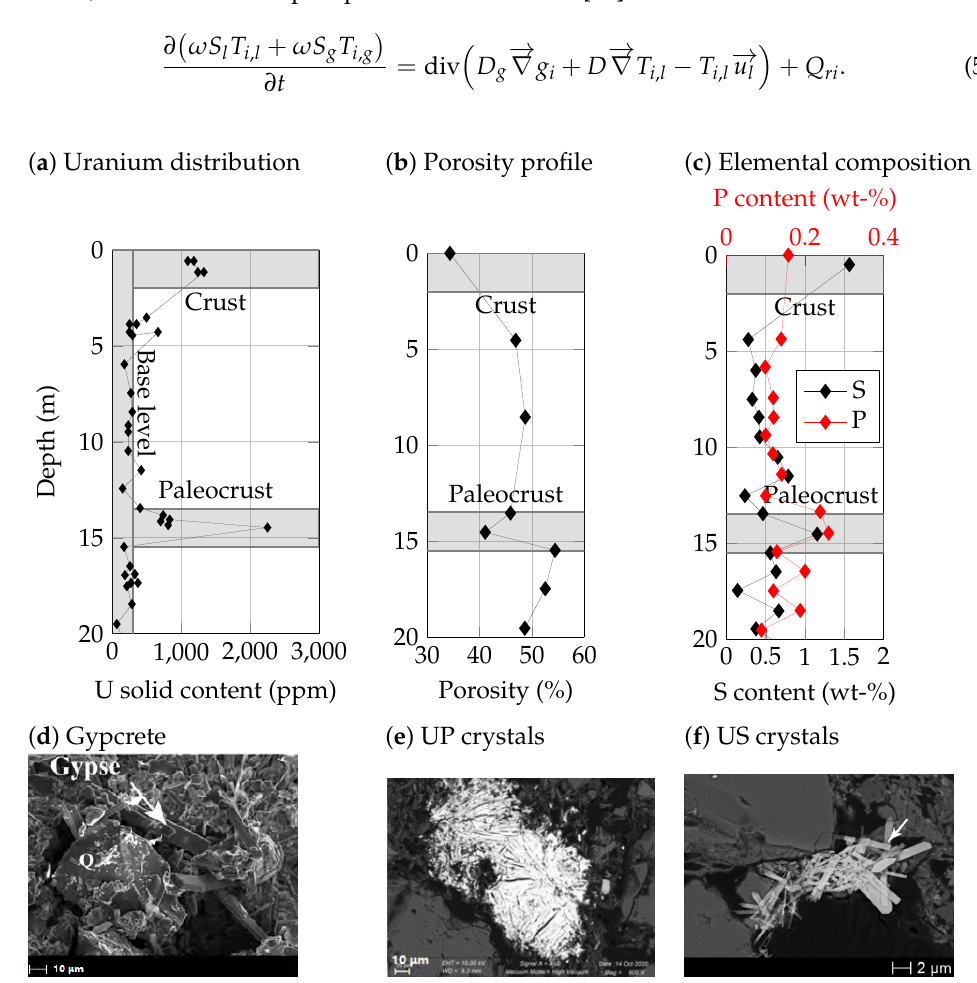
Figure 1. Experimental observations of the tailings evolution. ( a ) Vertical profiles of uranium content within the tailings showing two distinct levels of uranium enrichment. The top one is in contact with the atmospheric condition, which is subject to evaporation. The lower one corresponds to the old atmospheric boundary, which had been subject to evaporation for ≈ 10 years. Redrawn from [14]. ( b ) Porosity profiles showing two levels of reduced porosity corresponding to the levels of uranium enrichment. Redrawn from [15]. ( c ) The elemental profile of S and P within the tailings. ( d – f ) SEM-BSE images showing pore space filling with gypsum needles within the gypcrete ( d ), the presence of crystallized uranyl phosphate ( e ) and uranyl sulfate ( f )